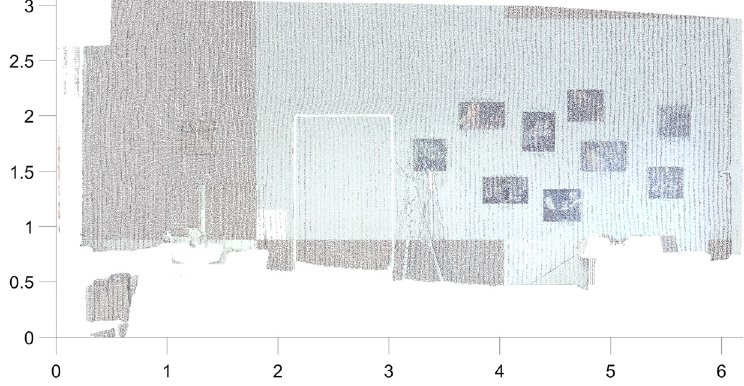
Figure 6. Segmented point cloud—only distance-based filtering.